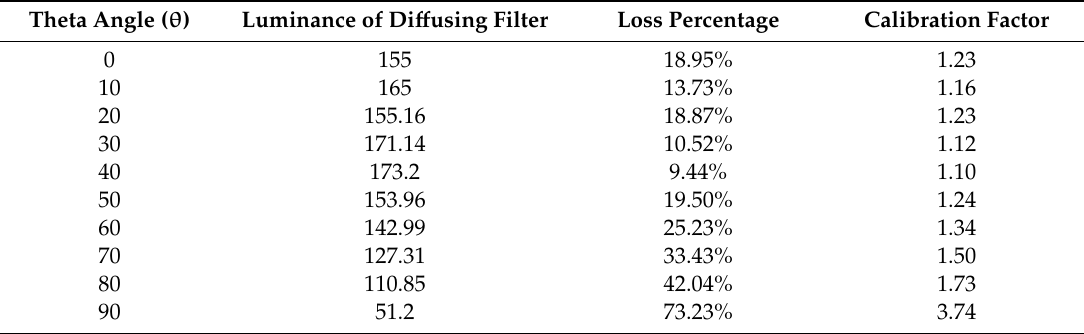
Figure14. ShowthecameravignettingcurvefortheSamsungGalaxyS7ontheleft, and3drepresentation of the calibration factor for each pixel on the right. Table 2. The relationship between the luminance of the di ff using filter calculated from HDRi and spot